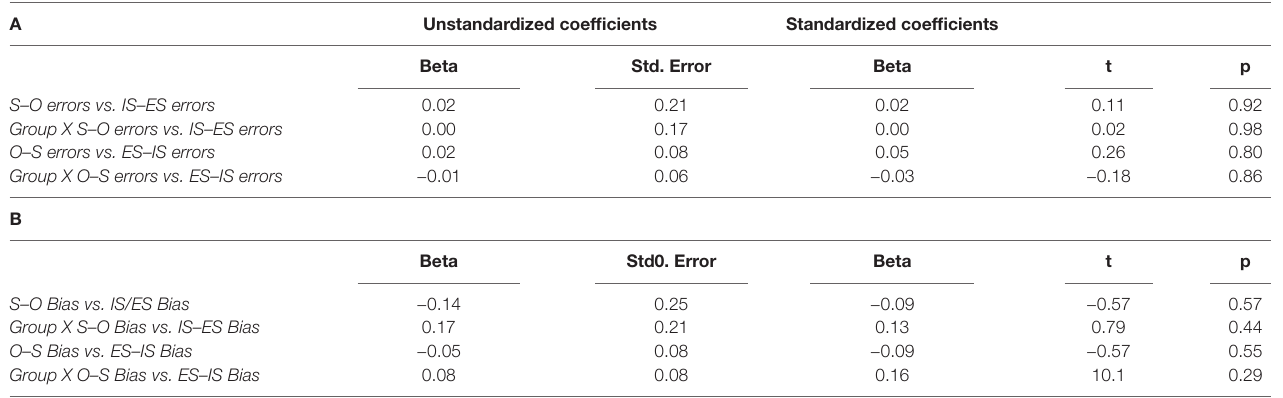
TABLE 3 | Results of linear regression analyses using misattribution error scores (A) and misattribution bias scores (B) .